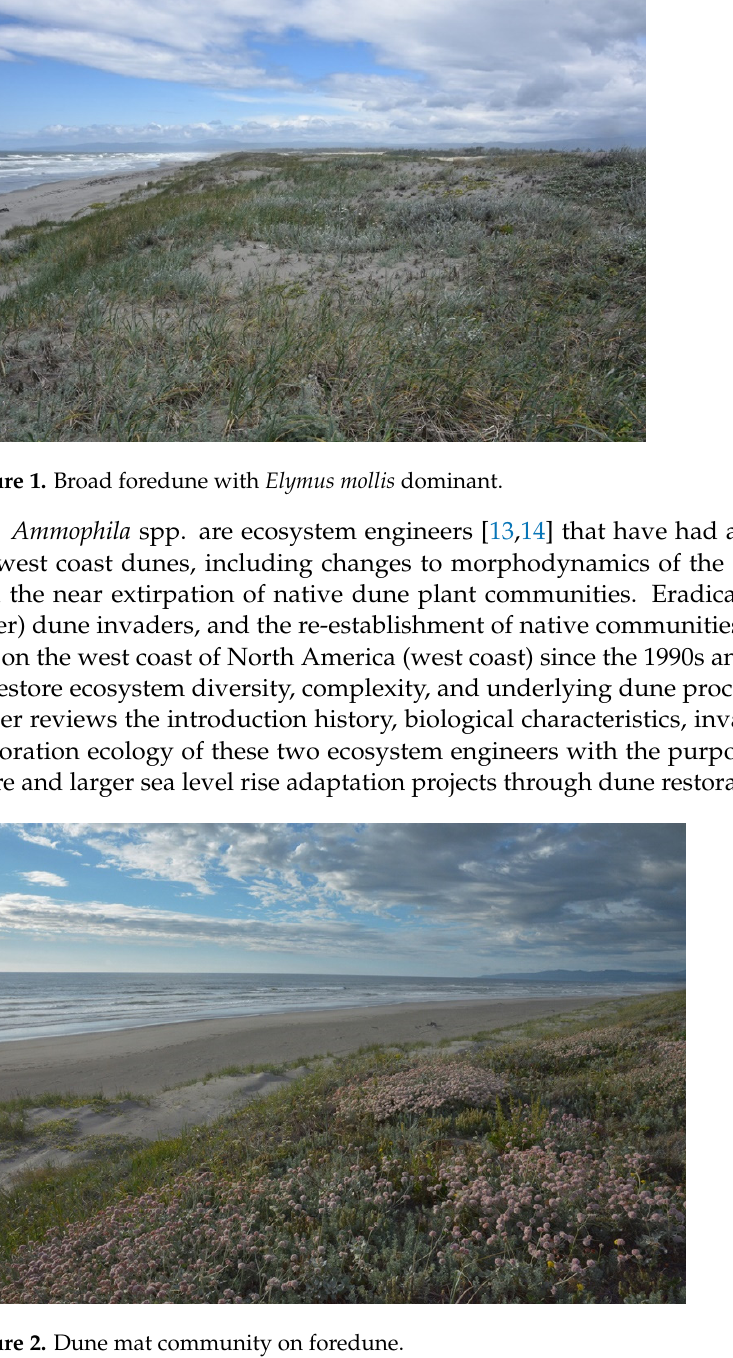
Figure 2. Dune mat community on foredune. 2. Biology, Introduction, and Spread 2.1. Ammophila arenaria Ammophila arenaria is an obligate psammophyte, dune-building grass native to the west coast of Europe and the north shore of the Mediterranean and Black Seas, stretching from 63° to 32° N [18]. It was introduced to the west coast at Golden Gate Park, San Fran- cisco, California as a stabilizer in 1869 [6,19], and to Oregon in 1910 [20]. From the time of